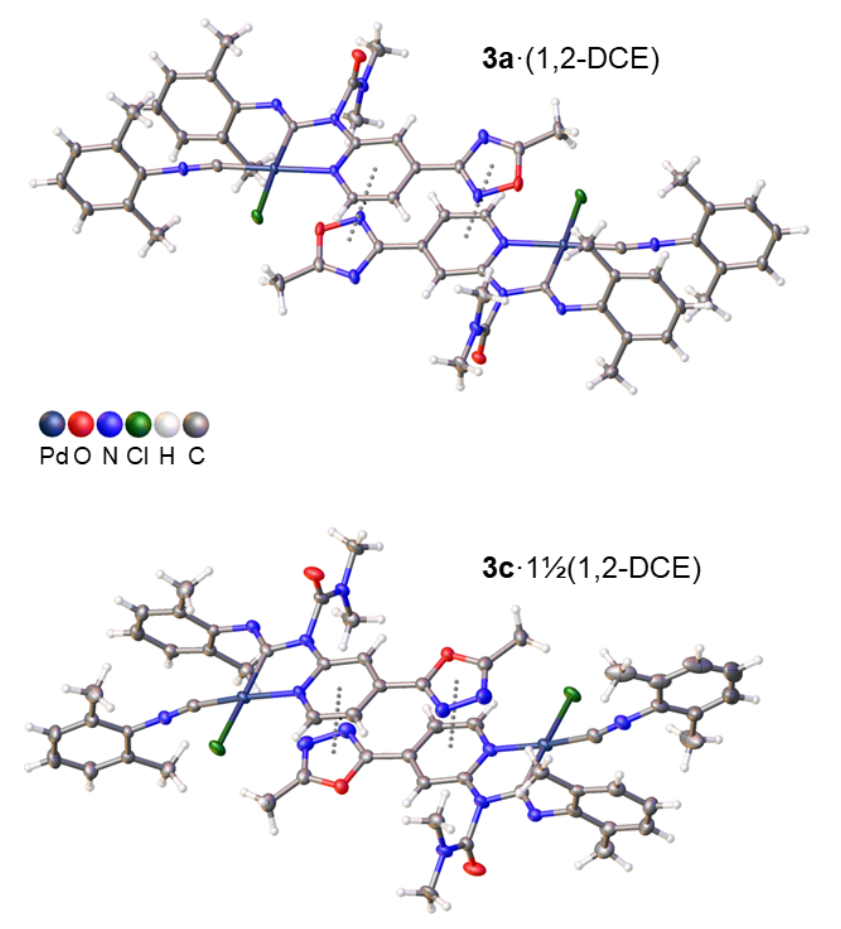
Figure 2. Oxadiazole–pyridine π ··· π interactions in the XRD structures of 3a ·(1,2-DCE) ( top ) and 3c ·1½(1,2-DCE) ( bottom ). Table 2. The cytotoxic activity of complexes 3a–d and cisplatin as reference compound determined by the MTT assay. The data presented were obtained from three independent experiments, and the values for IC 50 are mean ±